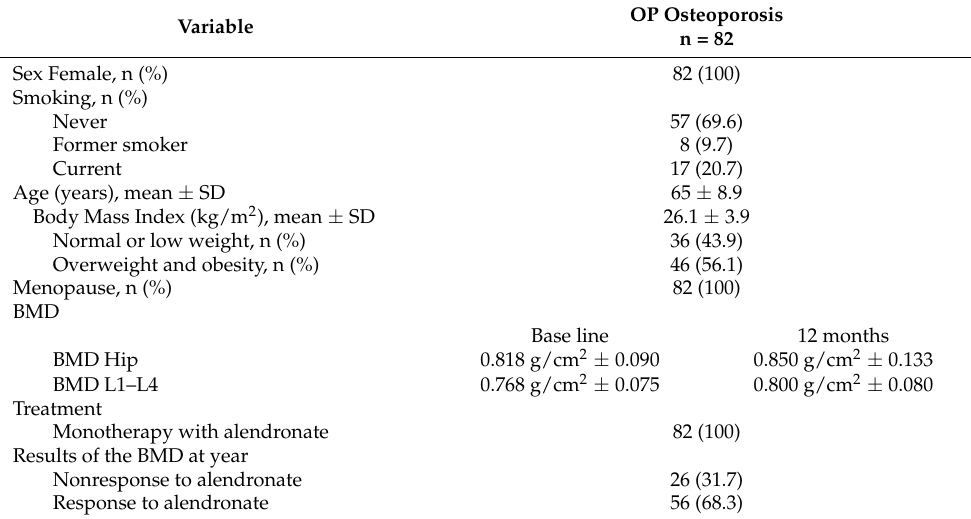
Table 1. Characteristic of osteoporosis